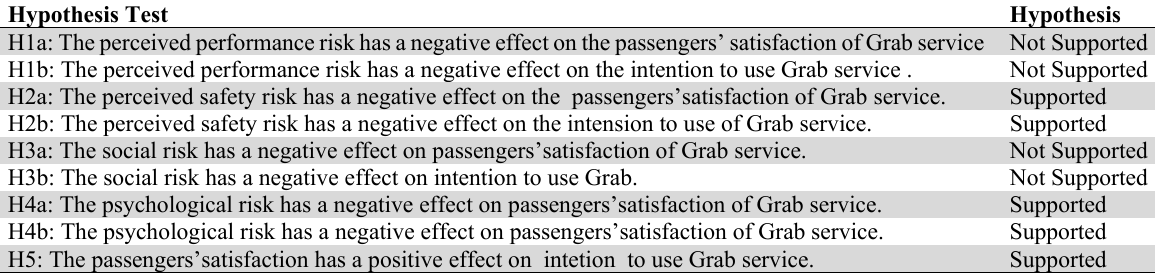
Results of the hypothesis test Hypothesis